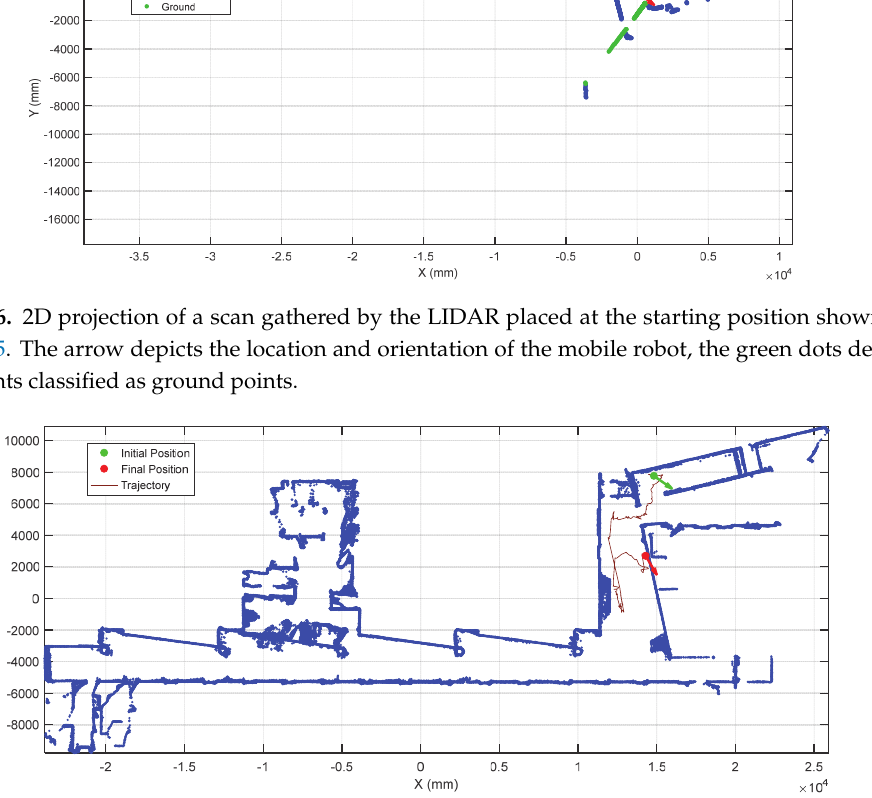
Figure 17. Estimated trajectory of the mobile robot with the 2D LIDAR tilted down 25° in one experiment performed in the stairs area of the facility.